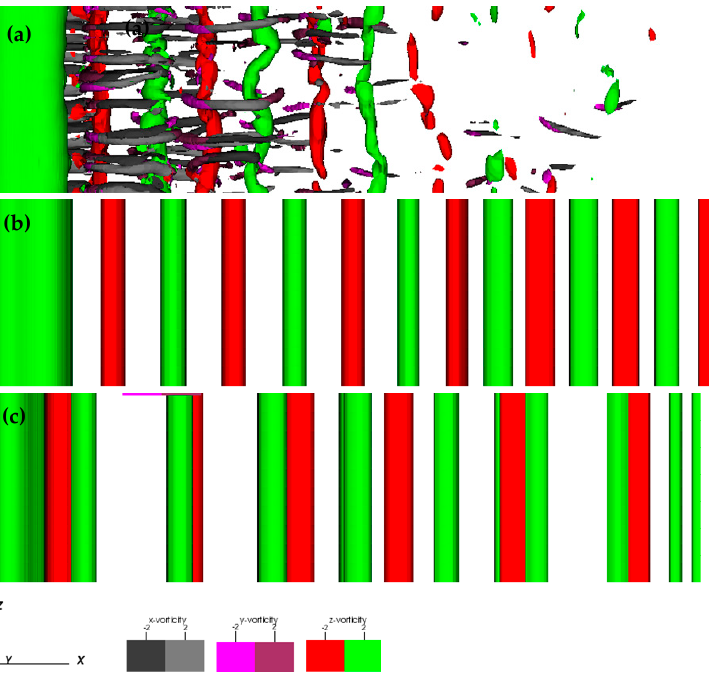
Figure 18. Clockwise cylinder oscillation: Instantaneous vorticity isosurfaces (top view) for F = 1.1 and ( a ) Ay/D = 0.10, ( b ), Ay/D = 0.30, ( c ) Ay/D = 0.60.